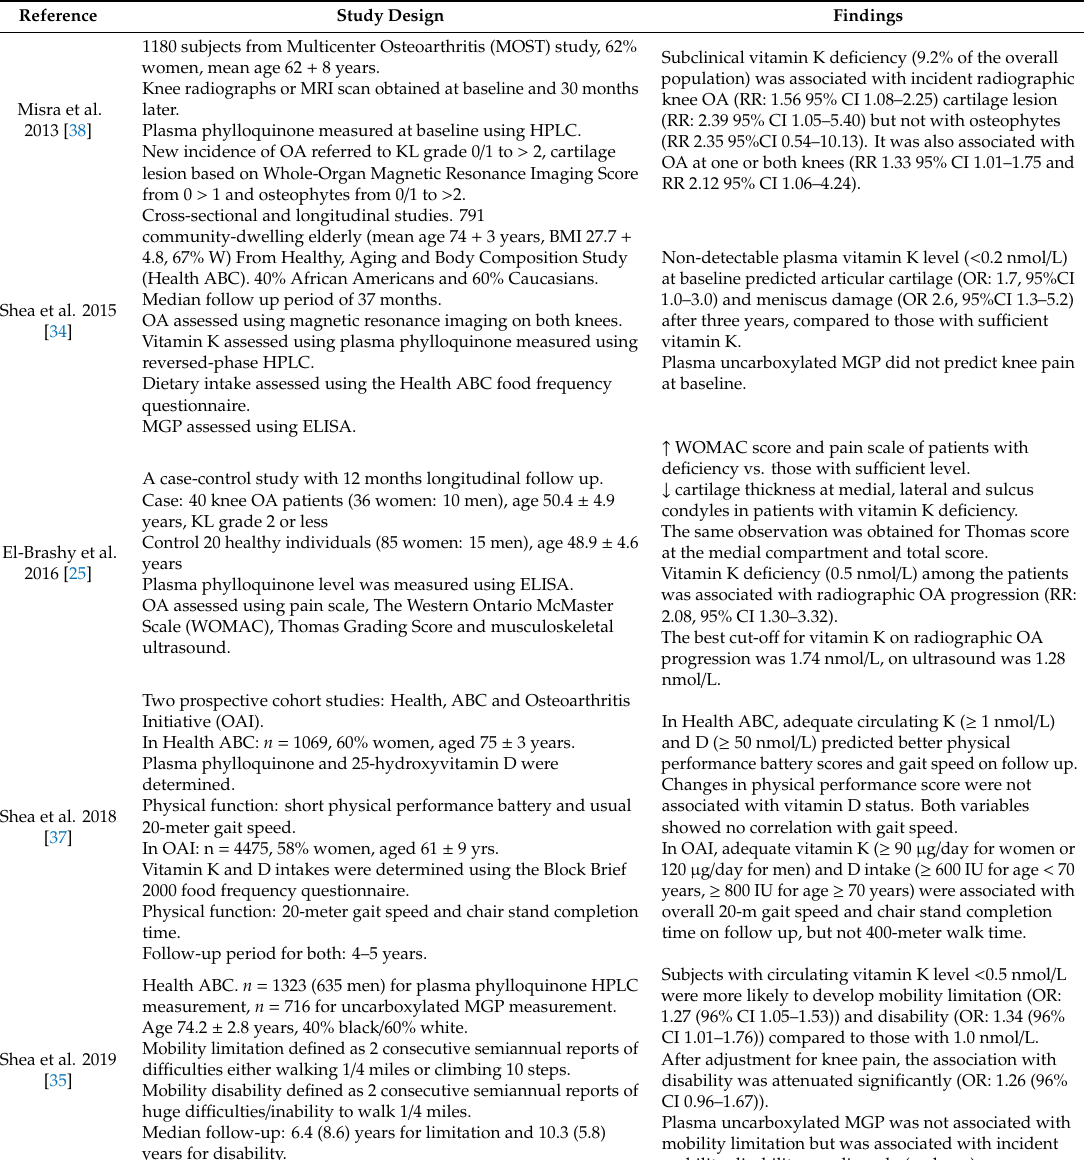
Table 3. The relationship between the vitamin K status and OA from prospective studies. Study Design